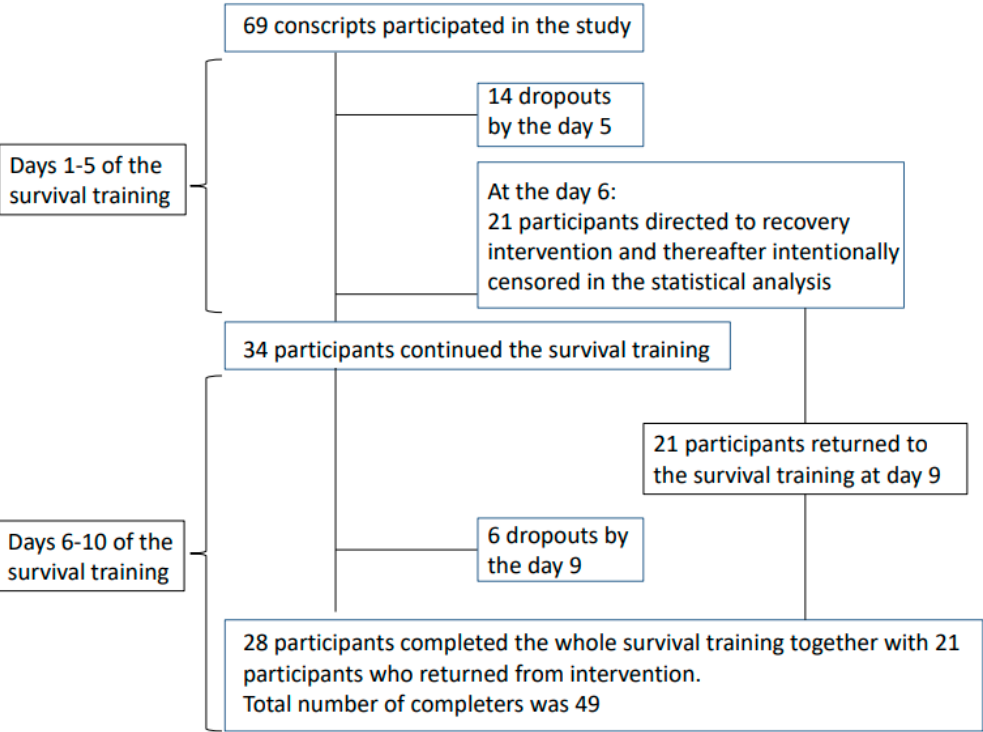
Figure 1. Flow chart of the participants during the military survival training. Table 1. Demographic, physical fitness, body composition, hormonal and psychological factors in those completing survival training and those who drop-out (mean + sd).